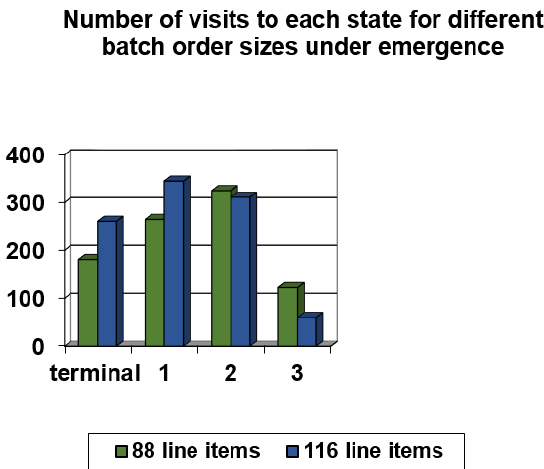
Figure 9. The number of agent visits to each state for the scheduling of one batch of 28 orders and four emergency orders, with mean order size (i) three line items per order; and (ii) four line items per order, when the agent selected the second policy action. The agent followed a non-ε-greedy policy with ε = 0.